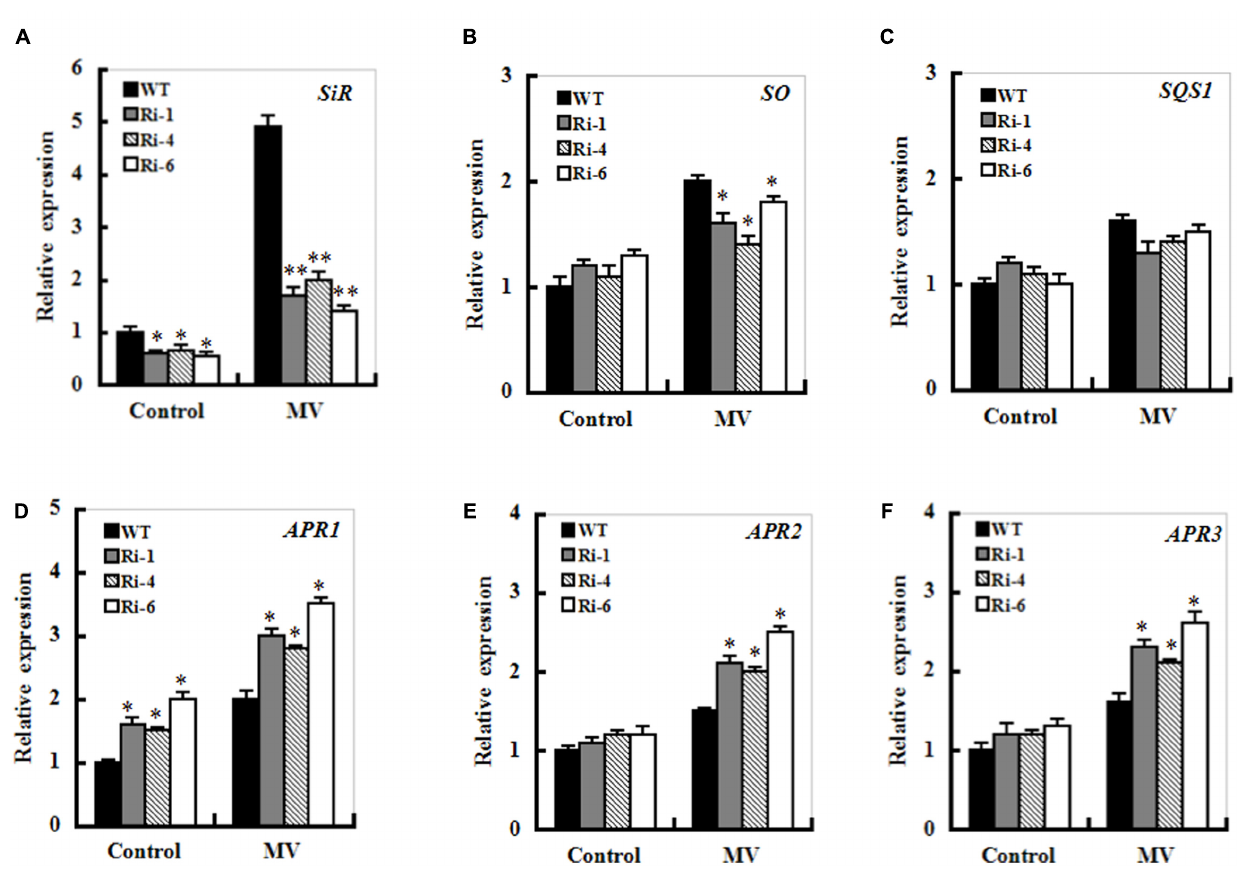
FIGURE 7 | Effect of SiR suppression on transcripts of the sulfite network genes under oxidative stress. Leaf samples from 5-week-old WT and three RNAi lines were harvested after 12 h of MV (20 µ M) spraying and transcriptional expression of SiR (A) , SO (B) , SQD1 (C) , APR1 (D) , APR2 (E) , and APR3 (F) was detected by qRT-PCR. mRNA levels of these genes were normalized to the transcripts of Actin2 in the same samples. For each assay, the expression level of WT under control conditions was taken as 1.0, and data represented mean ± SE of three biological replicates. ∗∗ t -test, with P < 0.01; ∗ t -test, with P <